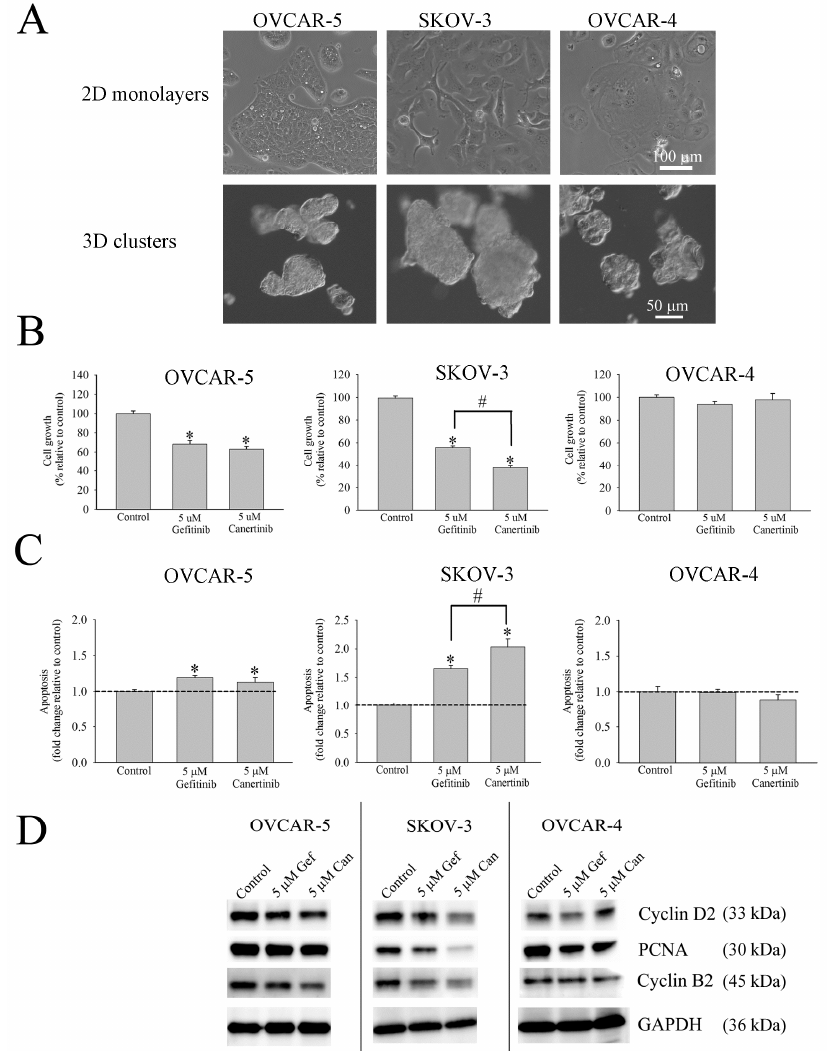
Figure 1. Effects of gefitinib and canertinib on three well established ovarian cancer cell lines cultured in 3D aggregates. Morphological appearances of OVCAR-5, SKOV-3, and OVCAR-4 are distinctive in monolayer. In 3D culture, both OVCAR-5 and OVCAR-4 form small clusters, but SKOV-3 cells form compact cell aggregates ( A ). Gefitinib and canertinib significantly reduce cell growth of OVCAR-5 cell clusters and SKOV-3 cell aggregates. OVCAR-4 cells do not show any growth response to inhibitors ( B ). Canertinib induces greater apoptotic cells in SKOV-3 cell aggregates than gefitinib ( C ). Proteins associated with the cell cycle, cyclin D2, PCNA, and cyclin B2, are reduced in SKOV-3 canertinib treated cell aggregates ( D ). Number of cells in control and treatment arms in Figure 1B were obtained by counting cells with a haemocytometer. Apoptotic cells were detected by Annexin V-FITC labelling cells and analysed with a flow cytometry. Representative analysis from a set of four independent experiments (Mean ± SE; n = 4) is presented and statistical significance was determined by a t -test ( * , p < 0.05).